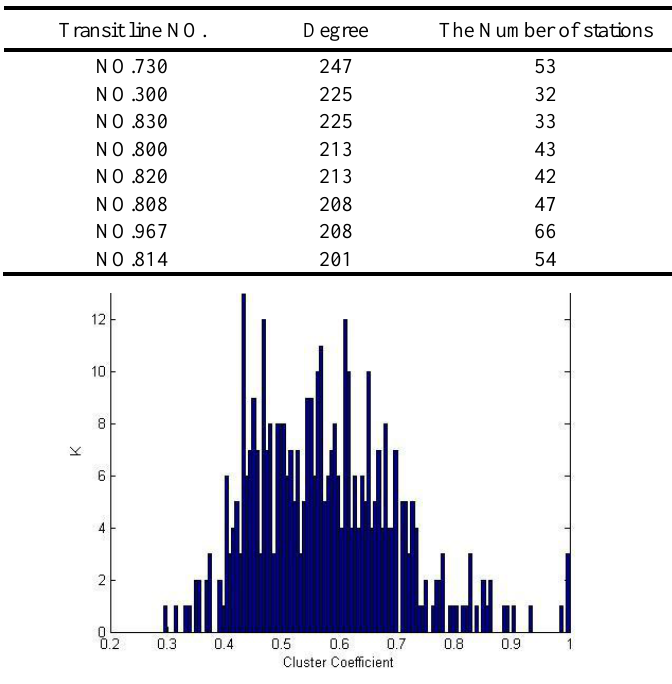
Table.2 The degree and number of stations of transit line with degree larger than 200. Transit line NO.